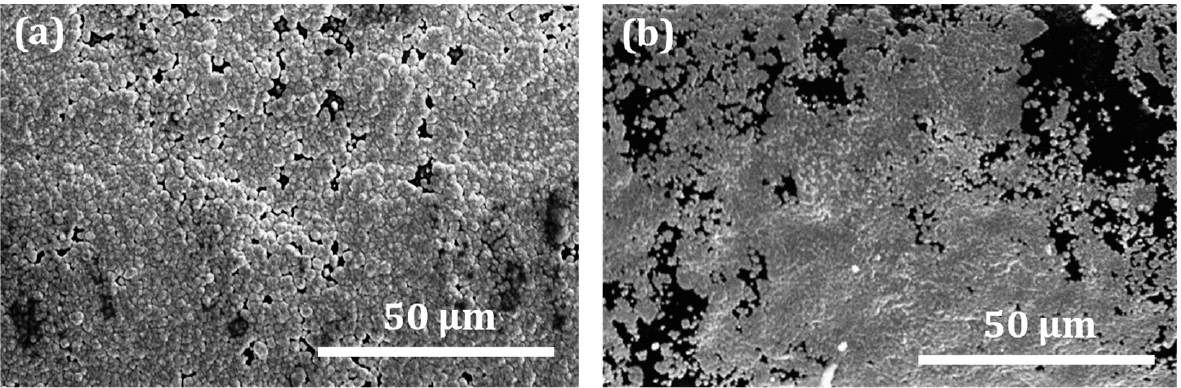
Figure 5. Morphology and microstructure of the copper coating on ABS part ( a ) and PC-ABS part ( b ).